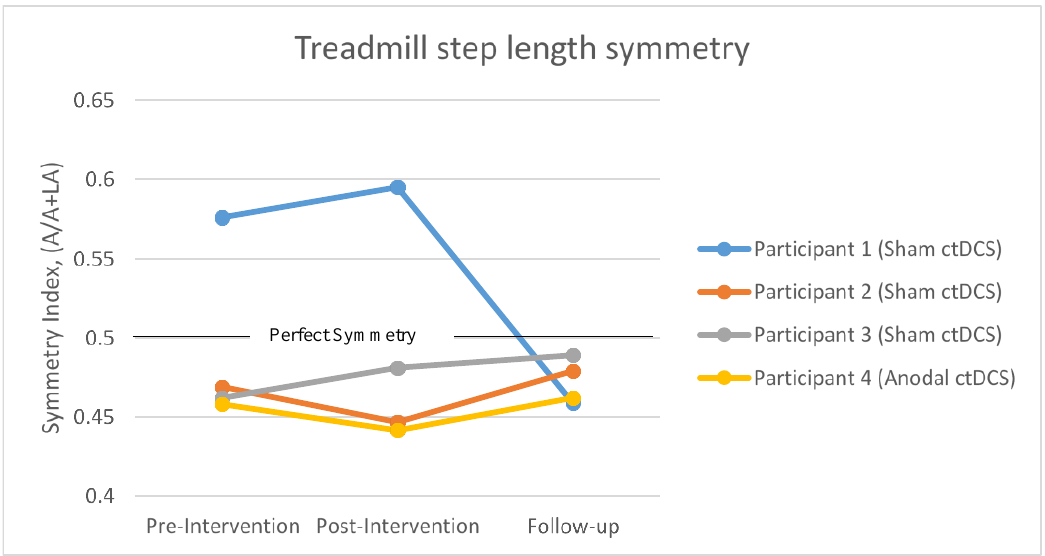
Perfect Symmetry